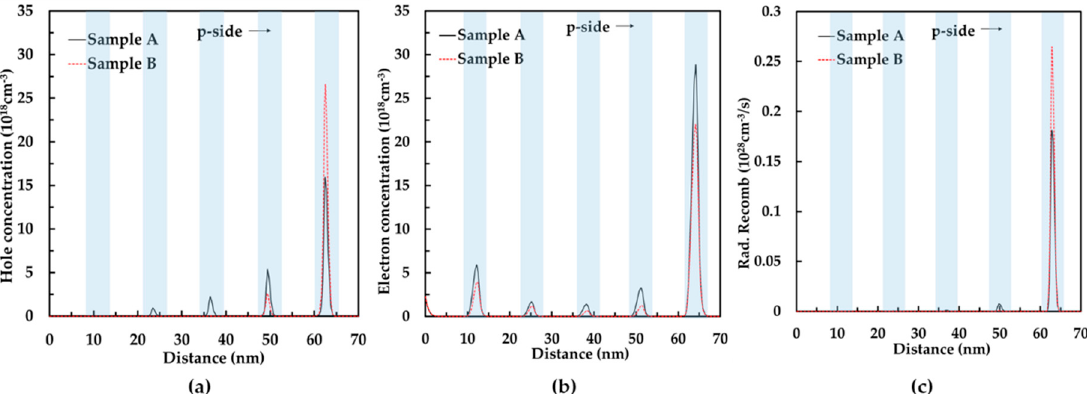
Figure 5. ( a ) Hole concentration distribution; ( b ) electron concentration distribution; and ( c ) radiation recombination rate distribution of samples A and B.